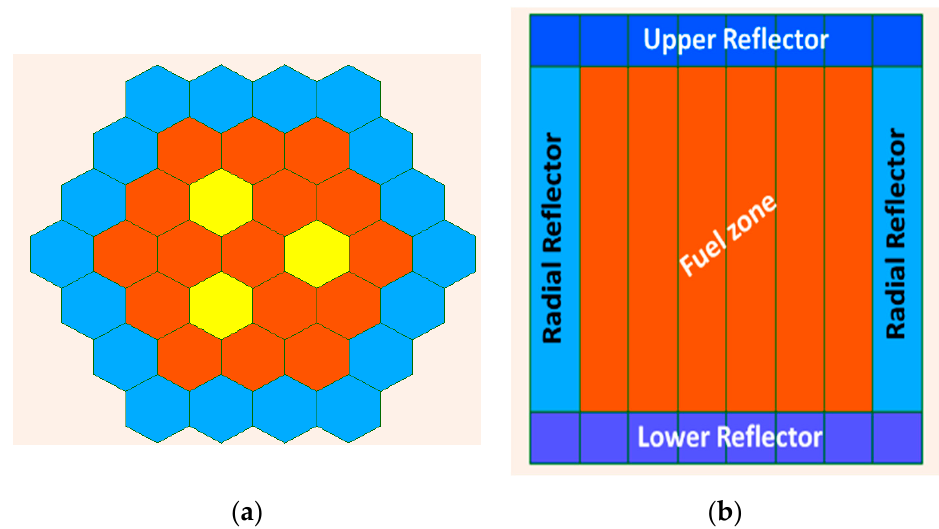
Figure 4. The 19 hexagonal FA minicore layout. Simplified scheme: ( a ) radial configuration; ( b ) axial configuration.